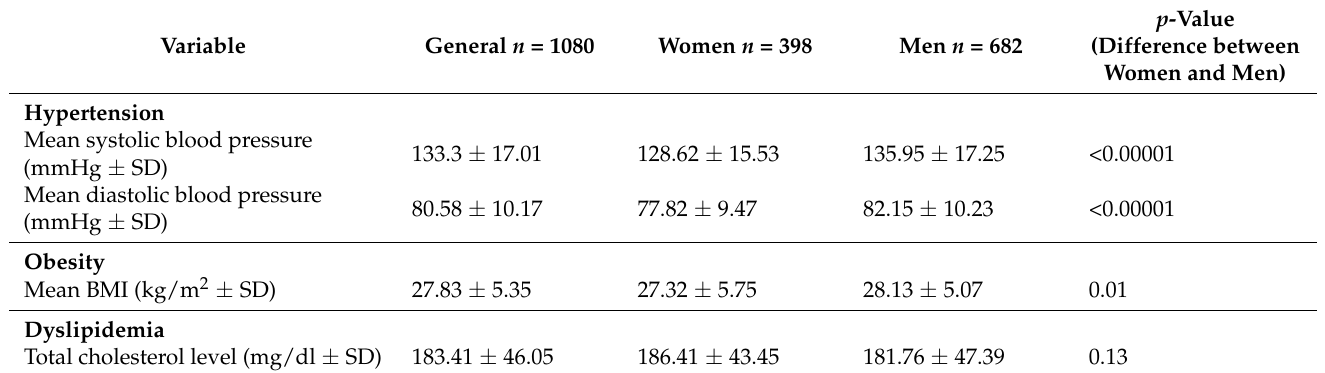
Table 2. The characteristics of the most prevalent comorbid diseases in psoriatic patients.